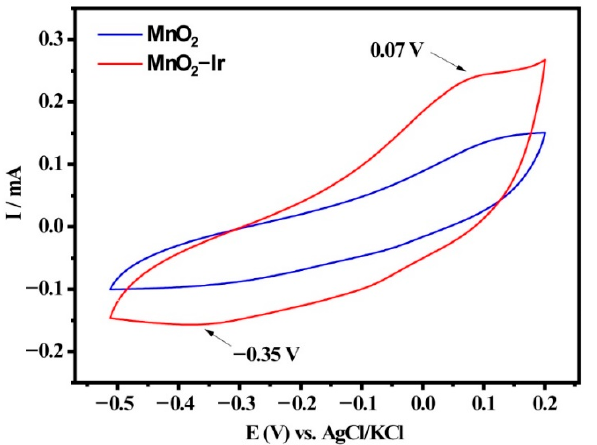
Figure 5. CV curves of the glassy carbon electrode modified with the bare MnO 2 nanowires and the MnO 2 -Ir electrocatalyst in an O 2 -saturated 0.1 mol L − 1 KOH solution at room temperature and a scan rate of 25